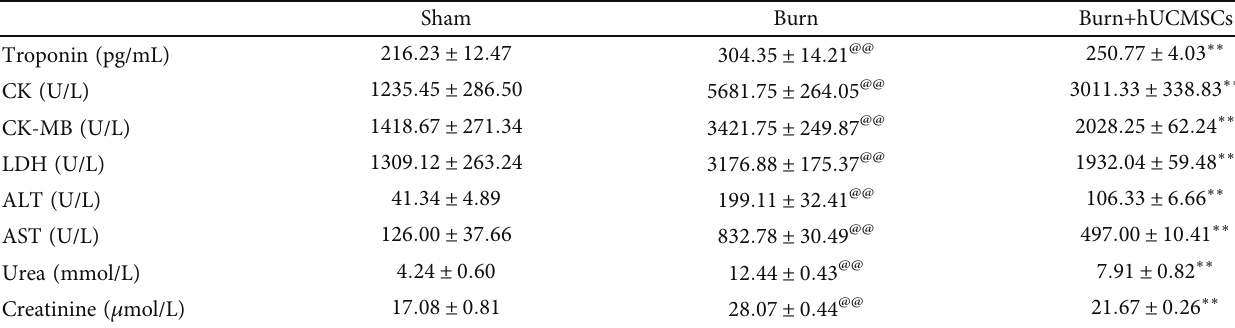
Table 1: The hUCMSC administrations signi fi cantly improved parameters of the heart, liver, and kidney functions. Serological biochemical analysis showed that high sensitive parameters of myocardial damage, such as troponin, CK, and CK-MB levels in the burn groups, were explicitly increased than those in the sham groups, and they were signi fi cantly decreased by hUCMSC administrations. The levels of liver function parameters ALT, AST, and LDH and kidney function parameters urea and creatinine in the burn groups were markedly higher than those in the sham groups, and their levels in the burn+hUCMSC groups were signi fi cantly lower than those in the burn groups. Sham Burn Troponin